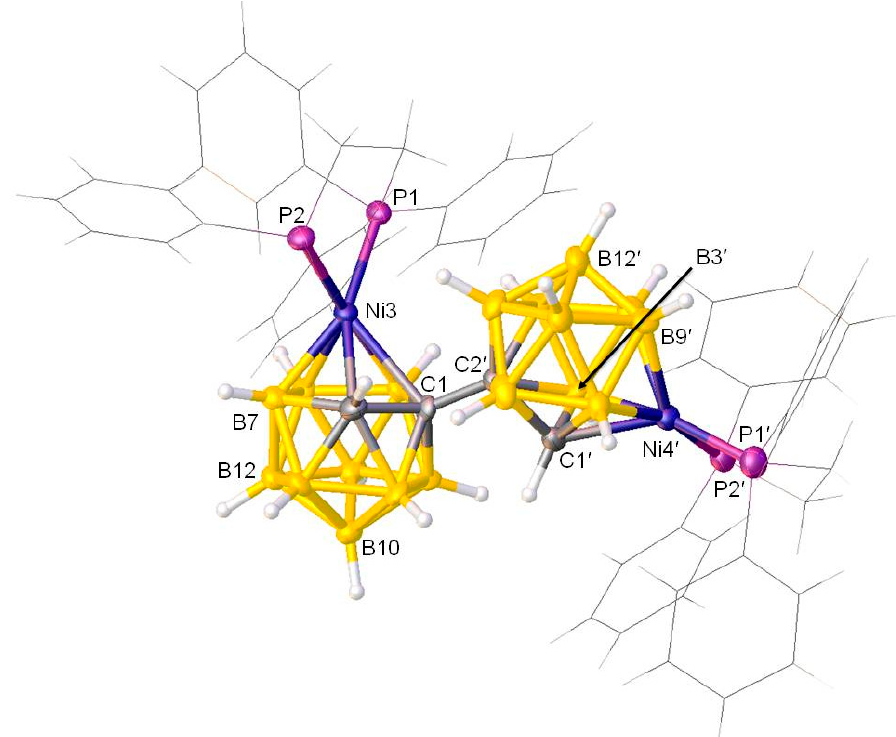
Figure 4. Molecular structure of [1-(2 ′ -4 ′ -(dppe)-4 ′ ,1 ′ ,2 ′ - closo -NiC 2 B 9 H 10 )-3-(dppe)-3,1,2- closo - NiC 2 B 9 H 10 ] ( 4 α ) (all phenyls and the –CH 2 -CH 2 - bridge of dppe are in wireframe for clarity).